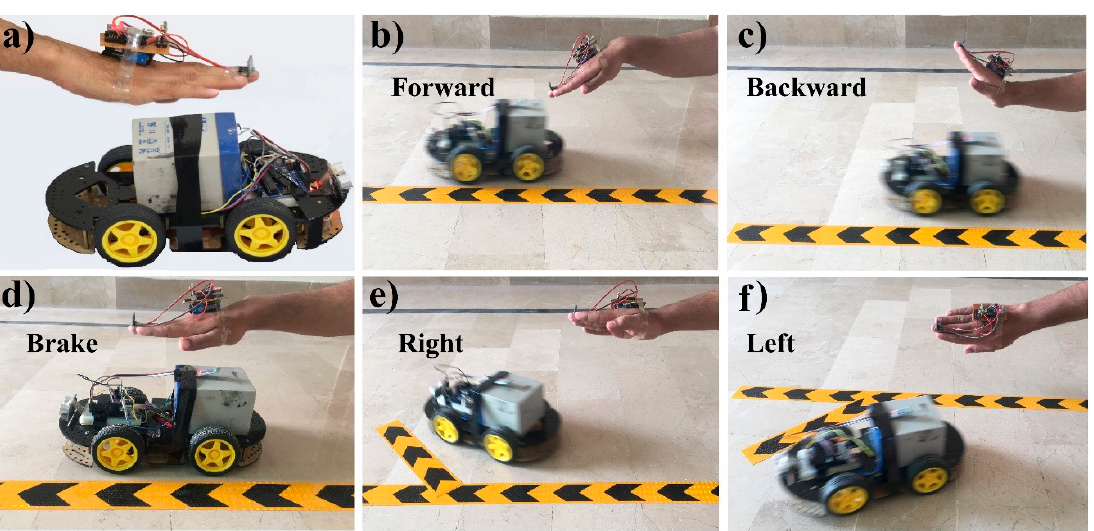
Figure 5. Result diagrams of the automatic robot car controlling system using hand-gestures. ( a ) Hand gesture and car’s hardware are illustrated ( b ) The hand is tilted in a downward position, so the car is moving forward. ( c ) The hand is tilted in the upward position, so the car is moving backward. ( d ) The car stopped when the hand is in a straight position. ( e ) The car is moving to right direction as the hand-tilted to the right side. ( f ) The hand is tilted to the left side, so the car is moving to left direction. The complete demonstration video of the proposed system is available online [85].